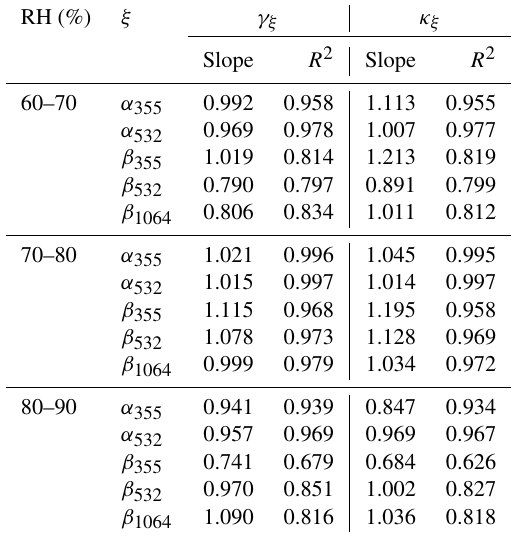
Table 3. Slopes of linear regressions and determination coefficients ( R 2 ) between γ ξ and κ ξ fitted from RH range 60%–90% and those fitted from limited RH ranges (60%–70%, 70%–80%, and 80%–